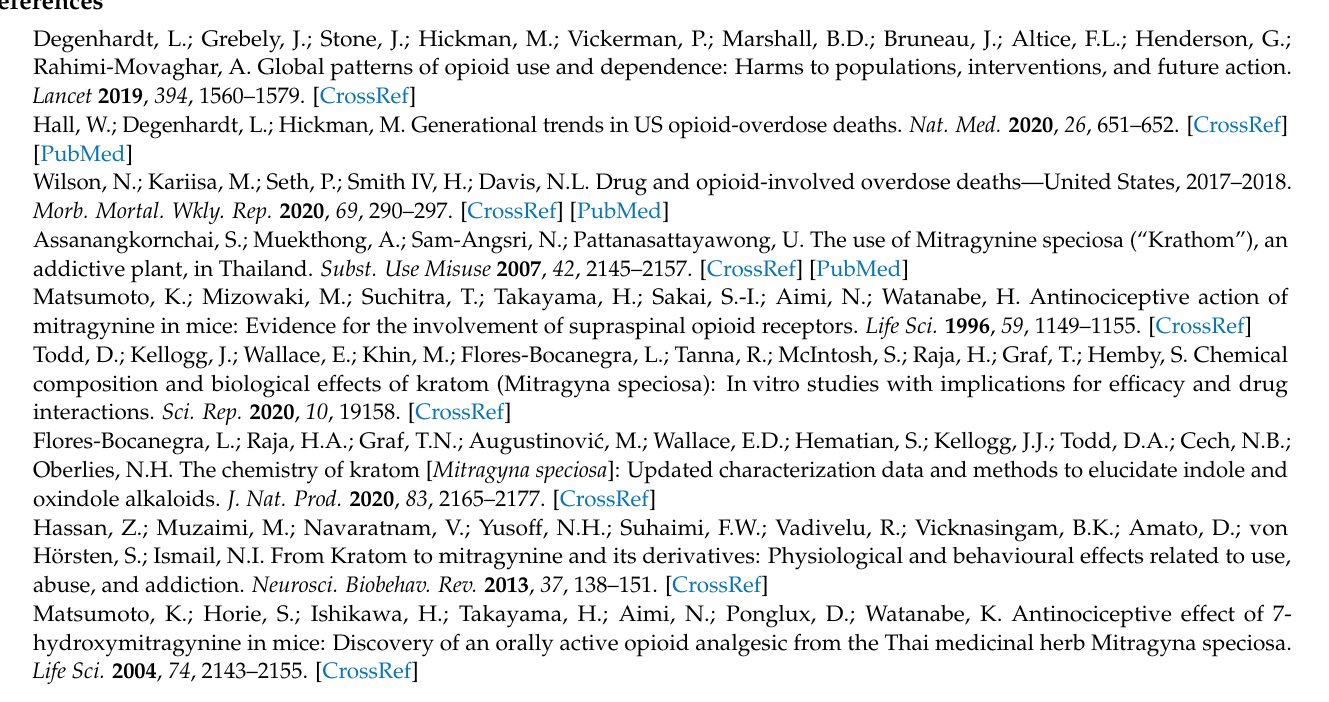
Figure S2: Representative concentration-time profiles from 0–12 h for each kratom alkaloid in one participant, showing multiple peaks or gradations, Figure S3: Compartmental analysis of the median alkaloid concentration-time profiles, Figure S4: Biphasic concentration-time profile for 7-hydroxymitragynine observed in two participants, Table S1: Clinical study inclusion and exclusion criteria, Table S2: Alkaloid content in commercial kratom product (K51), and supplemental text